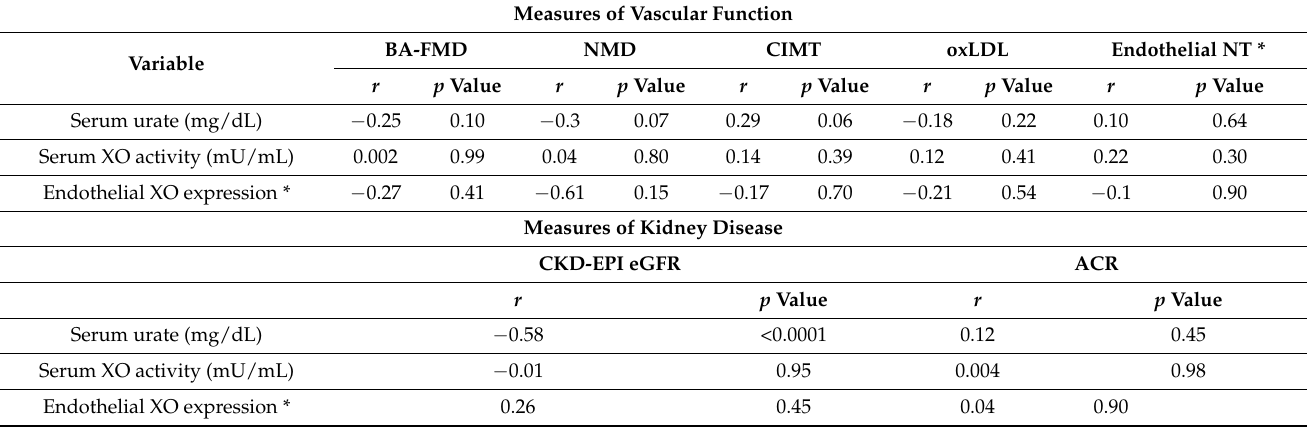
Table 2. Baseline correlation between serum urate, XO activity, and endothelial XO expression and measures of vascular and kidney